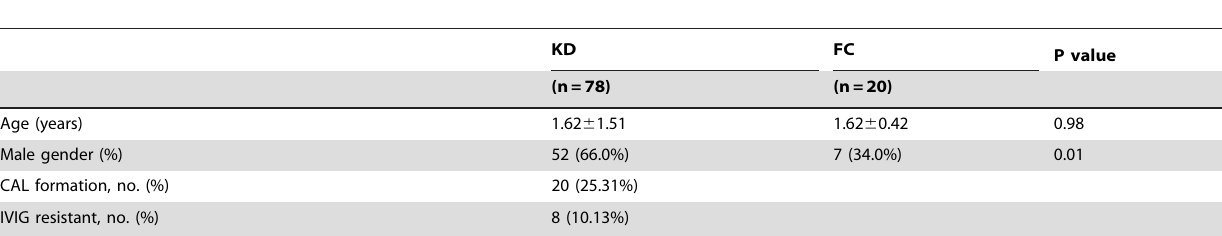
Table 1. Demographic data of Kawasaki disease patients and the control